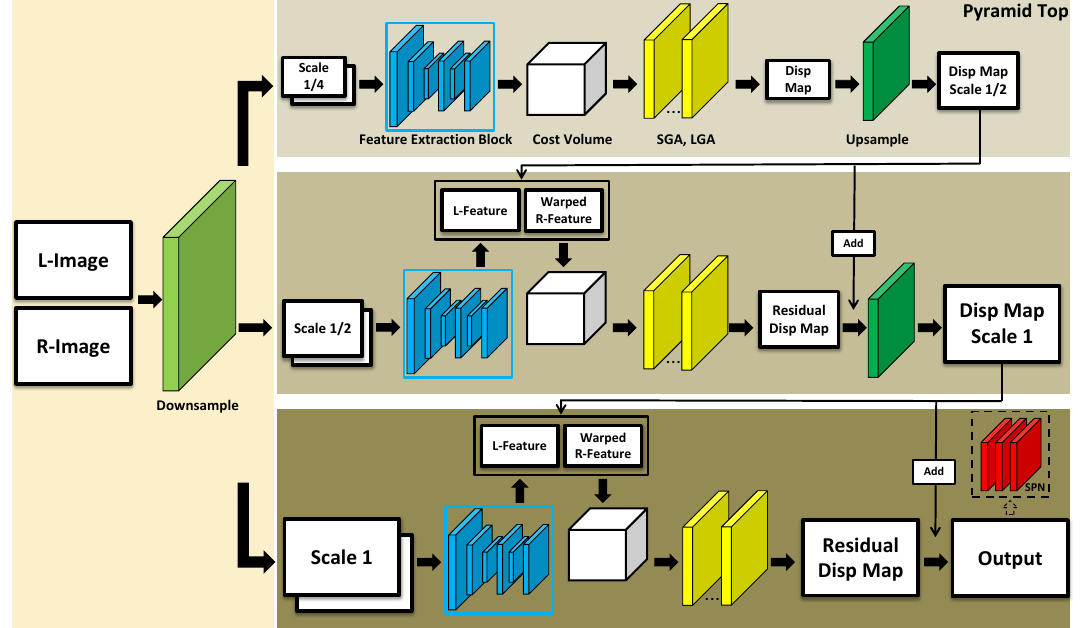
Figure 1. GA-Net-Pyramid with explicit downsampling. The input stereo pair is downsampled explicitly according to the resolution required by each pyramid level. At the pyramid top, the stereo correspondences are located within an absolute disparity range in low resolution. The following pyramid levels perform disparity refinement within a pre-defined residual disparity range until the original resolution is recovered at the pyramid bottom. SPN indicates the Spatial Propagation Network which is an optional module for depth boundary enhancement, as described in Section